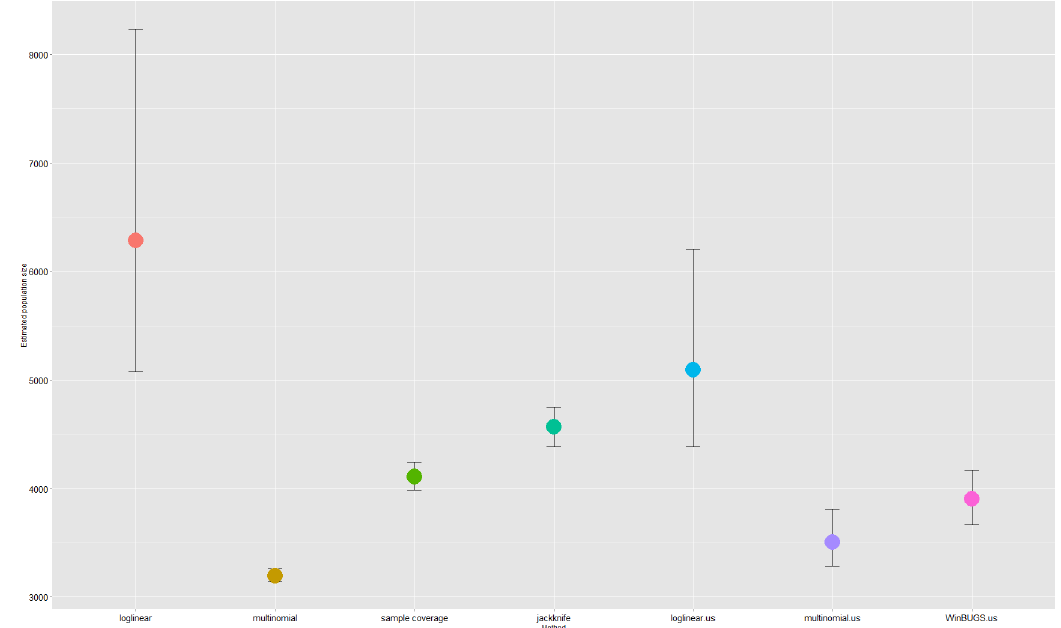
Fig 8. Overview of the seven different estimators for the IPD study and their 95% confidence intervals.